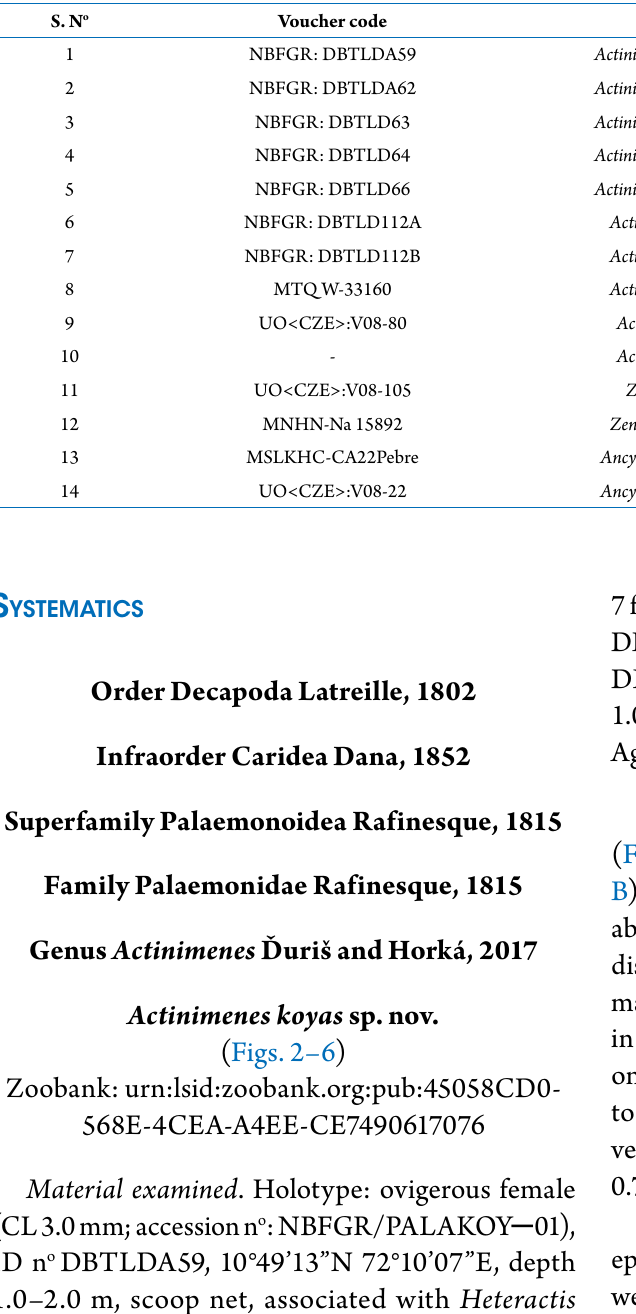
Table 1. Details of DNA sequences of Actinimenes koyas sp. nov., two other Actinimenes species and outgroup species obtained from GenBank.